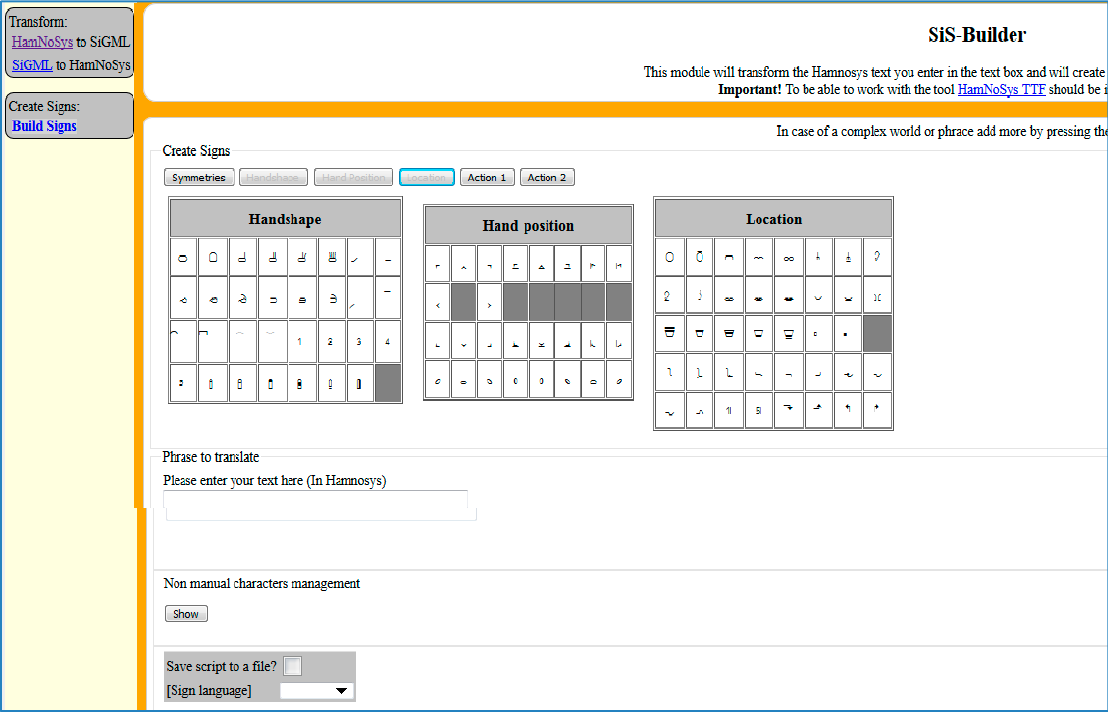
Figure 5. Creating HamNoSys notations online in the SiS-Builder environment.